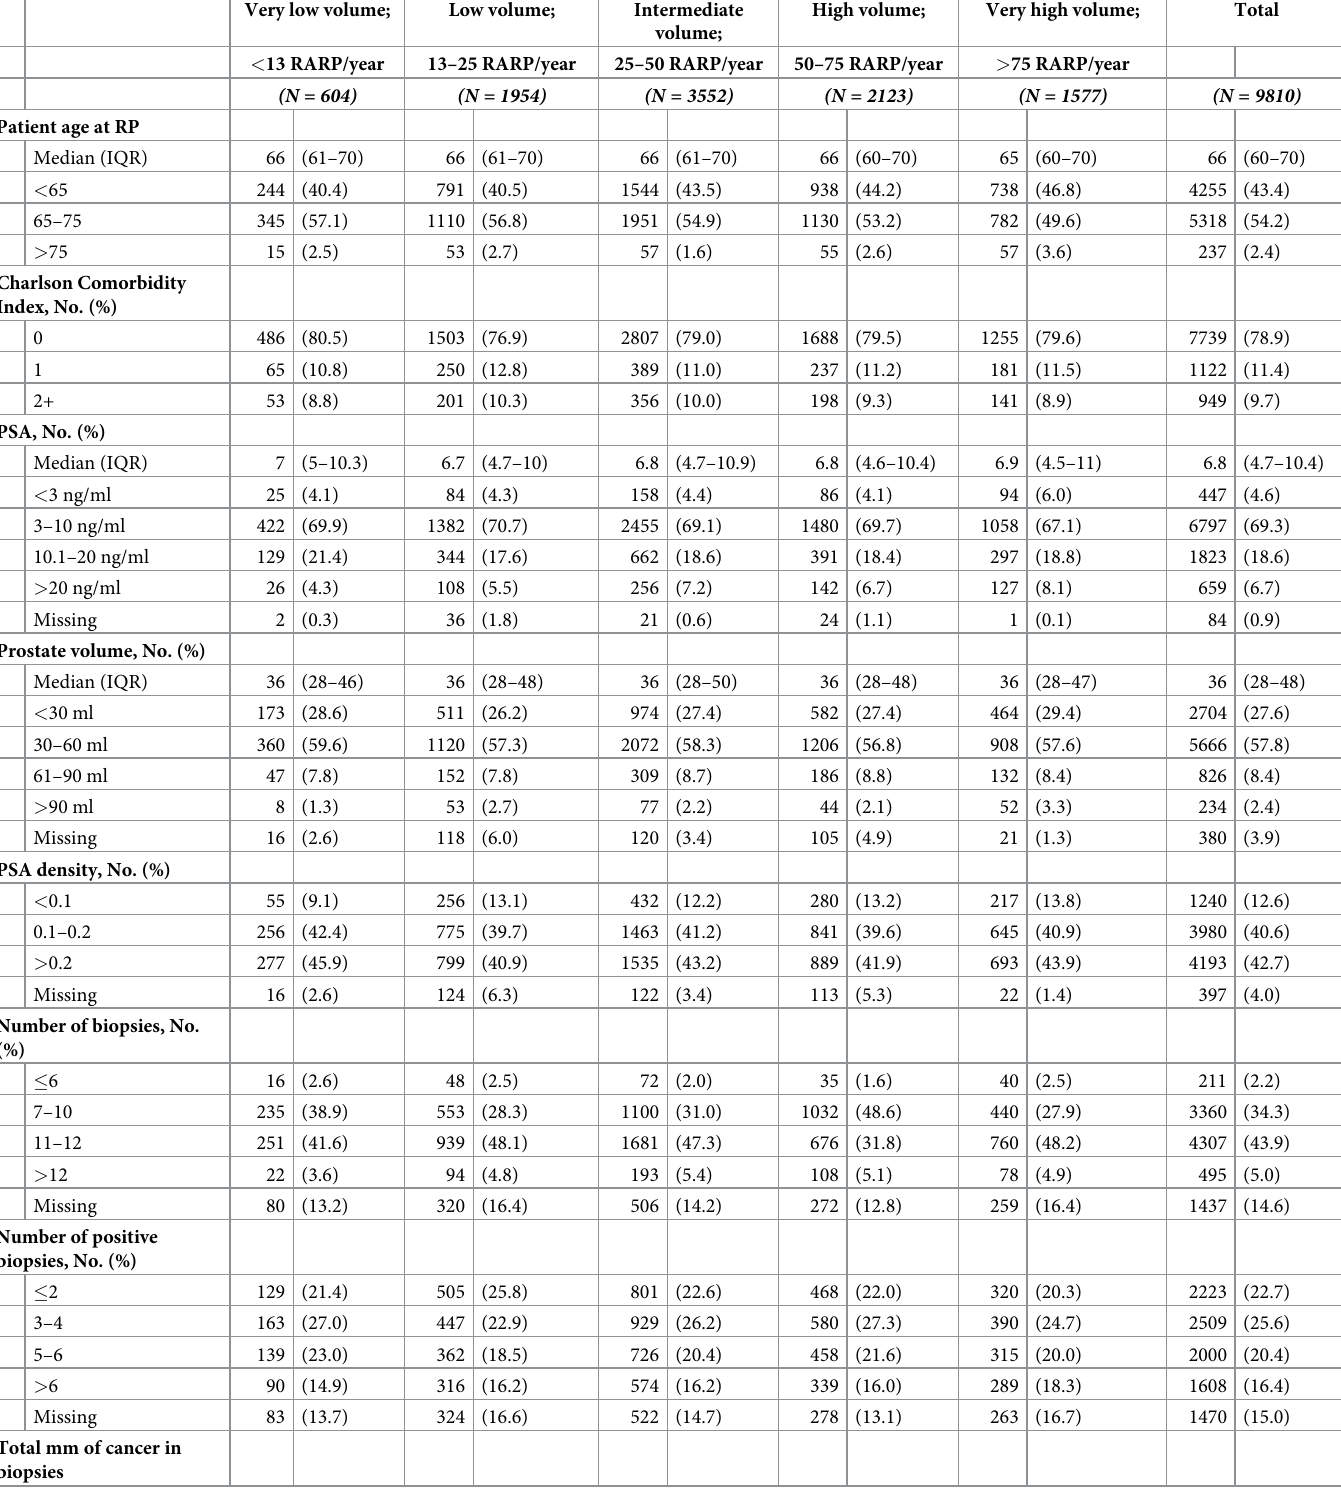
Table 1. Baseline characteristics in Prostate Cancer data Base Sweden (PCBaSe) according to surgical volume; number of robot assisted radical prostatectomies (RARP) performed by a single